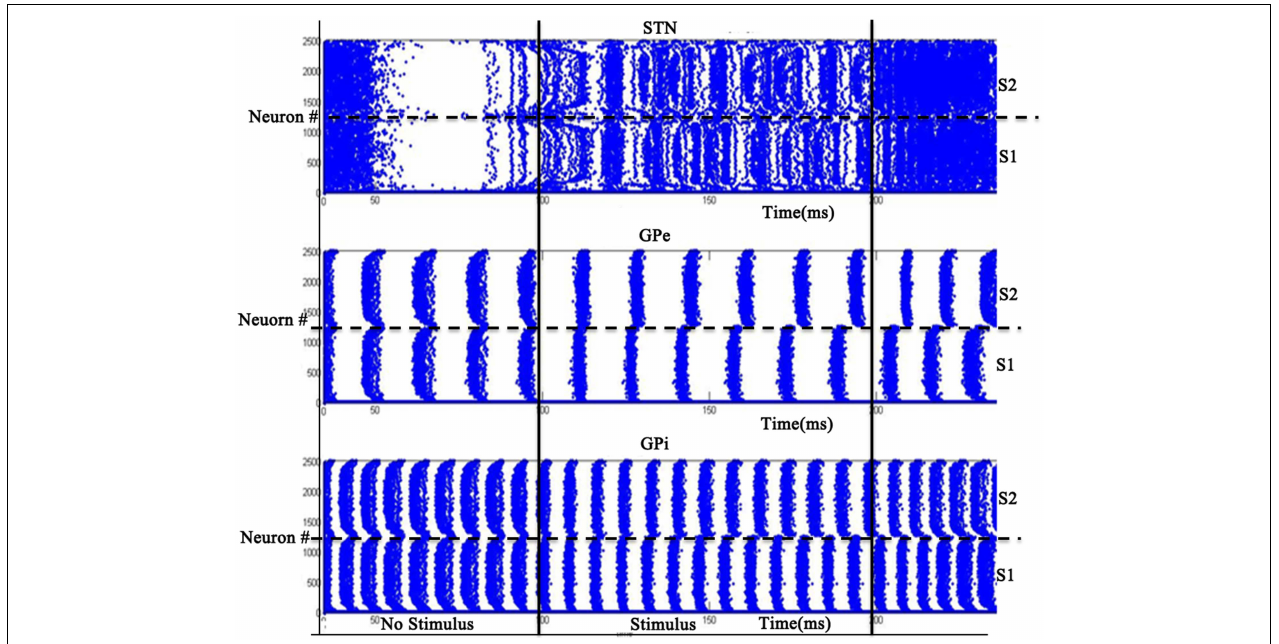
FIGURE 11 | Model Activity at intermediate DA ( = 0.5) with alternating behavior in GPi activity. Where x-axis represents the time of spiking and y-axis is the spatial representation of 2500 neurons. S1 and S2 represent the 2 stimuli given to the network spatially.